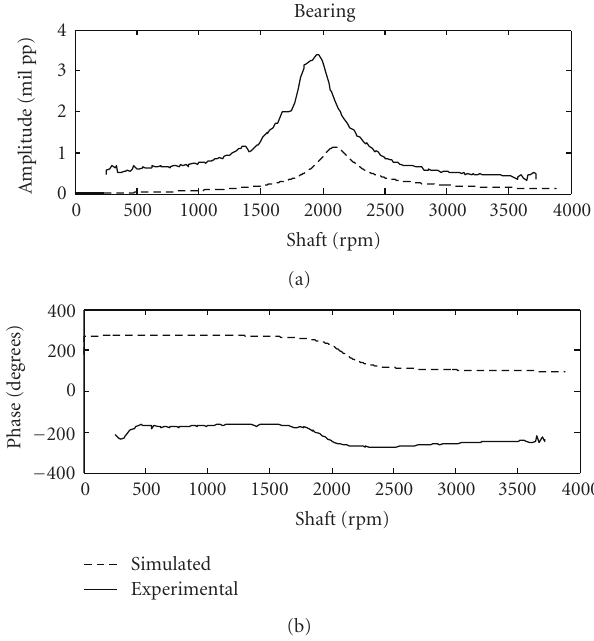
Figure 17: Synchronous response of a bowed rotor at outboard bearing. Ro = 1.09, ao = 180